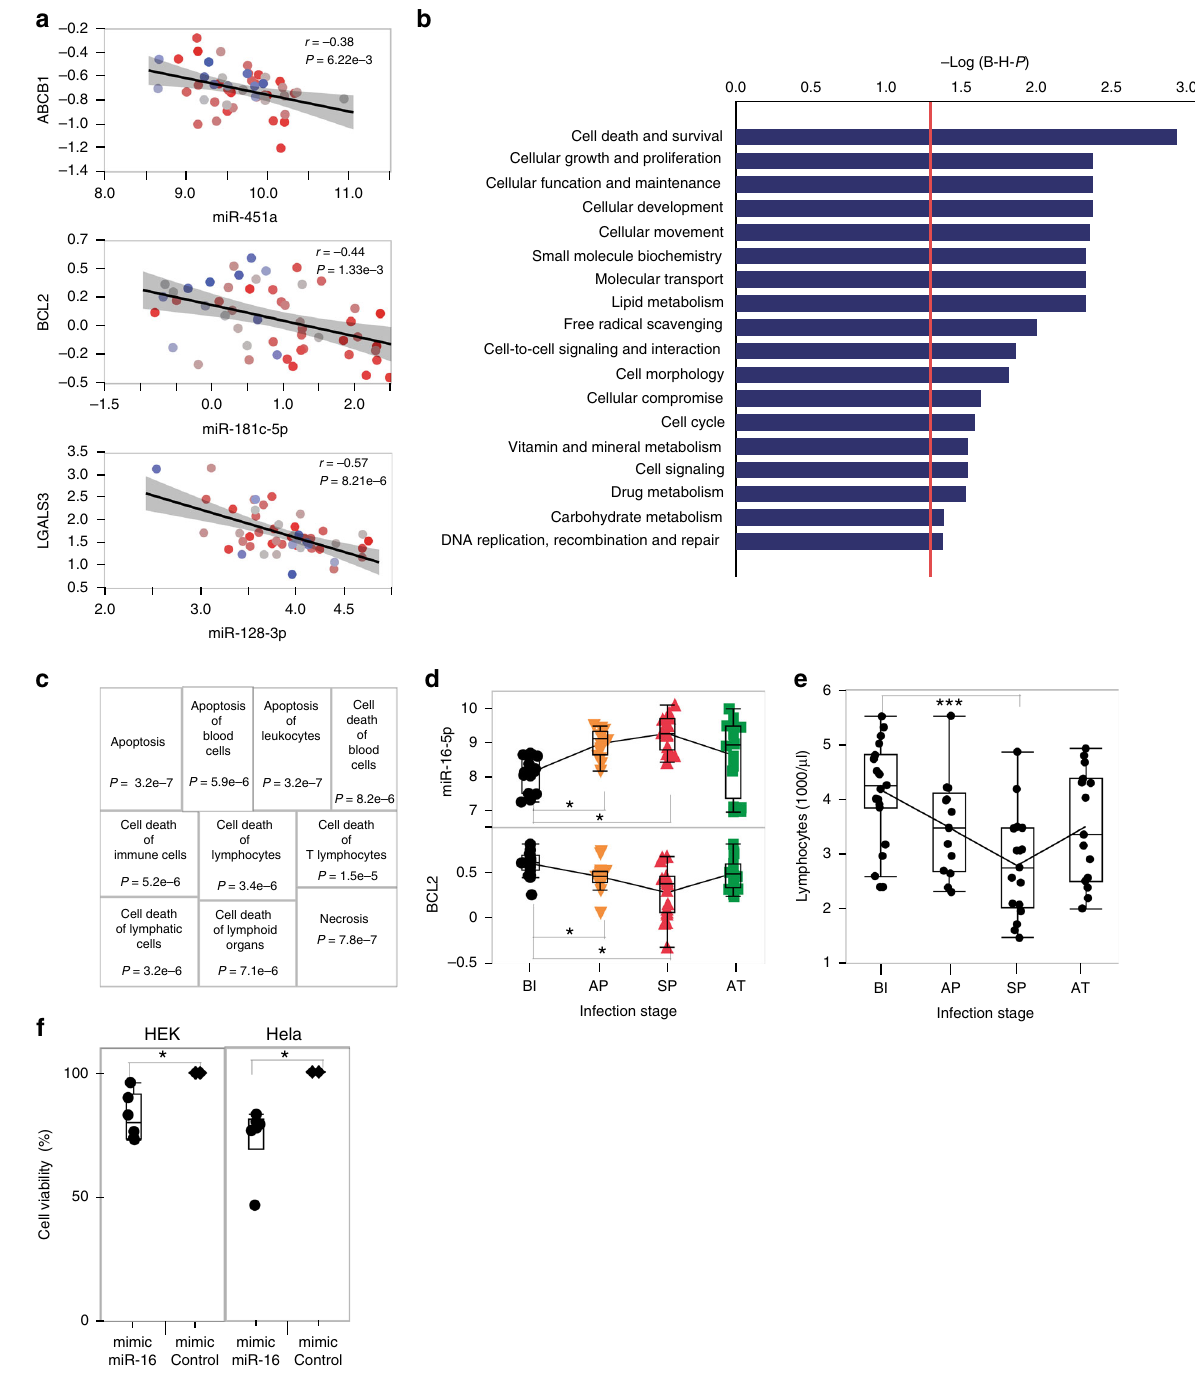
Table 1). The full list of cis -miR-eQTLs associations including the results of permutation tests is provided in Supplementary Data 8. The strongest association (B-H FDR-adjusted P =